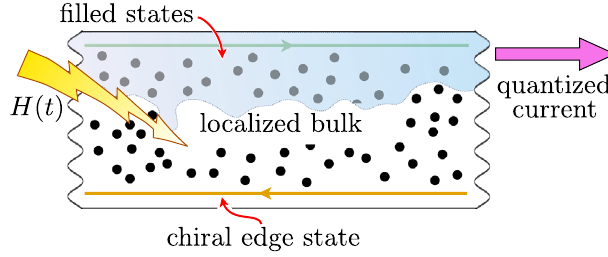
FIG. 1. The anomalous Floquet-Anderson insulator (AFAI), in a disordered two-dimensional periodically driven system with time-dependent Hamiltonian H ð t Þ . In the AFAI phase all bulk states are localized, yet the system hosts chiral propagating edge states at all quasienergies. The nontrivial topology of the phase is characterized by a nonzero value of the winding number defined in Eq.